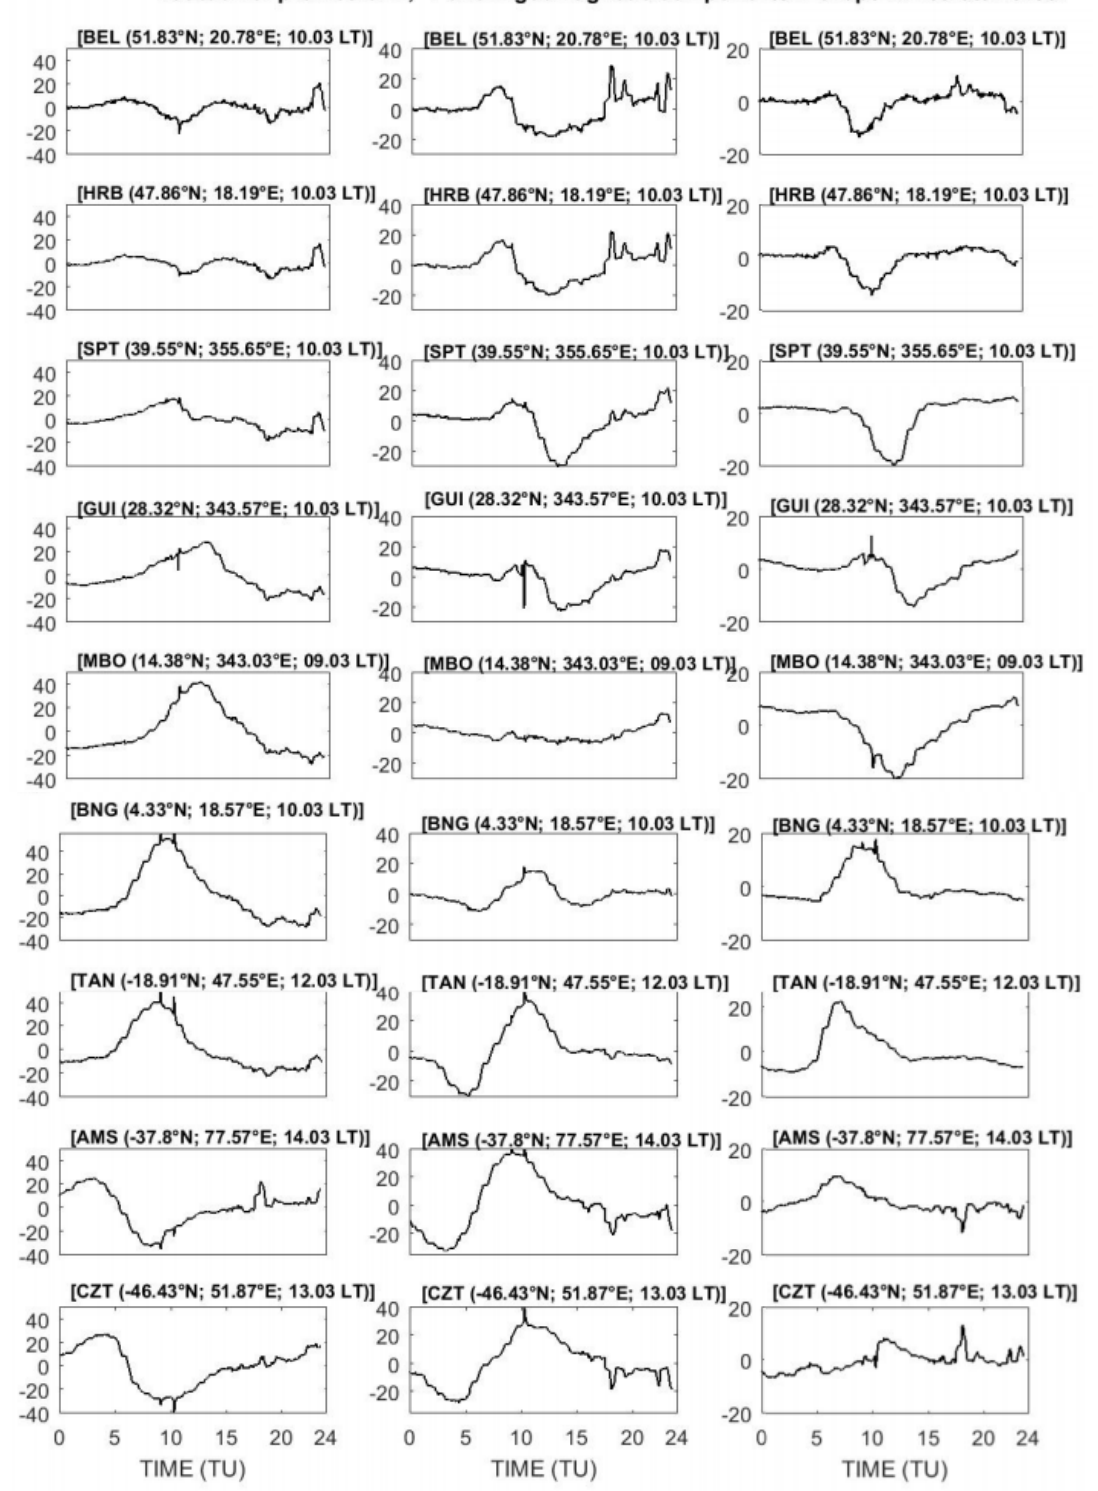
Figure 8. Variation of horizontal (H), eastward (Y) and vertical (Z) components of the geomagnetic field during the M1.4 and M4.2 solar flares of 3 November 1997.